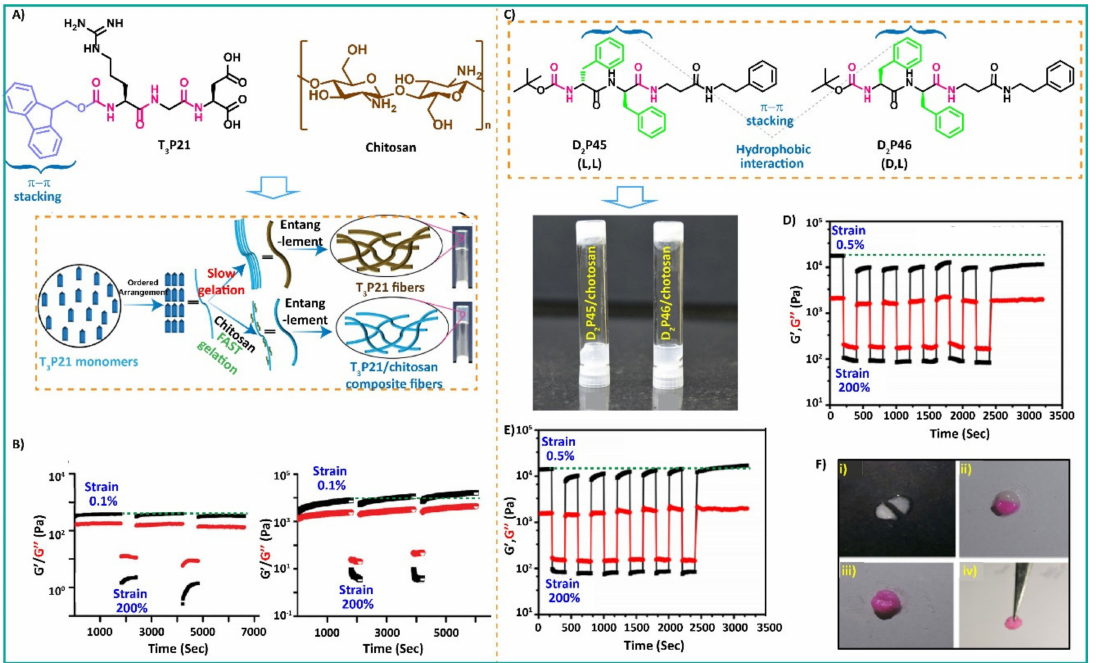
Figure 19. ( A ) Chemical structure of the tripeptide biopolymer, chitosan; schematic model of self-assembly process to form fibrous nanostructures and digital photographs of T 3 P20 and T 3 P20/Chitosan hydrogel. ( B ) Rheological step-strain analysis of T 3 P20 and T 3 P20/chitosan hydro- gel; reproduced with permission from Ref. [176]. Copyright (2019) John Wiley and Sons. ( C ) Molecular structure of the dipeptides (D 2 P45 and D 2 P46) and digital photographs of D 2 P45-46/chitosan hy- drogel. ( D , E ) Rheological thixotropic measurement of D 2 P45-46/chitosan hydrogel. ( F ) Self-healing characteristics of the gels; reproduced with permission from Ref. [178]. Copyright (2020)